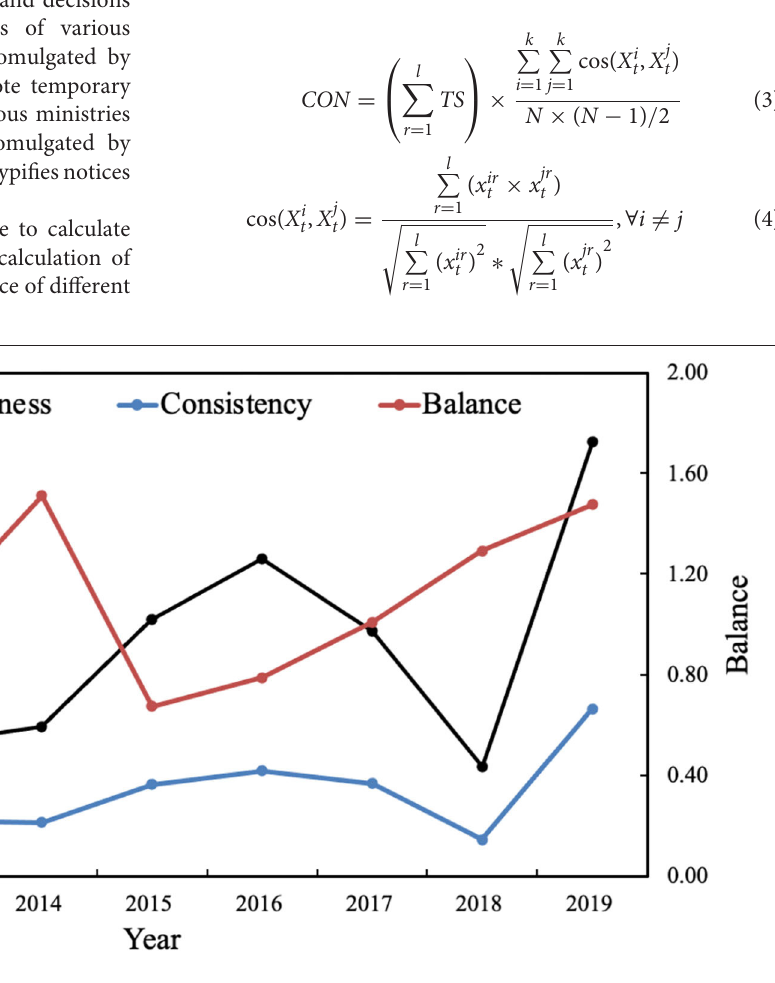
Frontiers in Public Health |